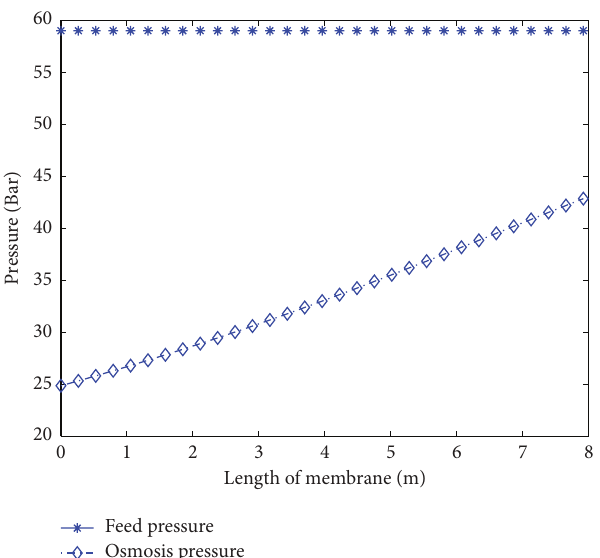
Figure 9: Osmosis pressure along the membrane.